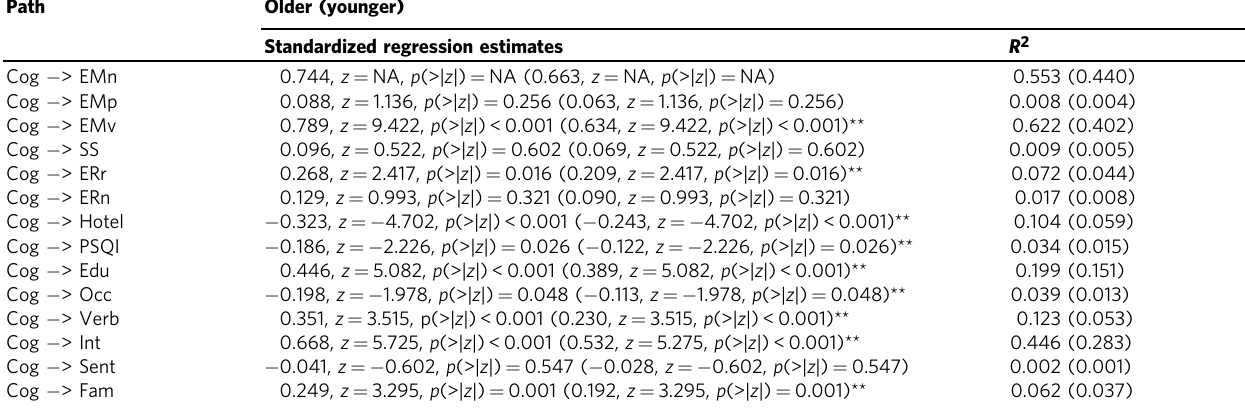
Table 3 Unidimensional, age-adjusted, multi-group model. Path Older